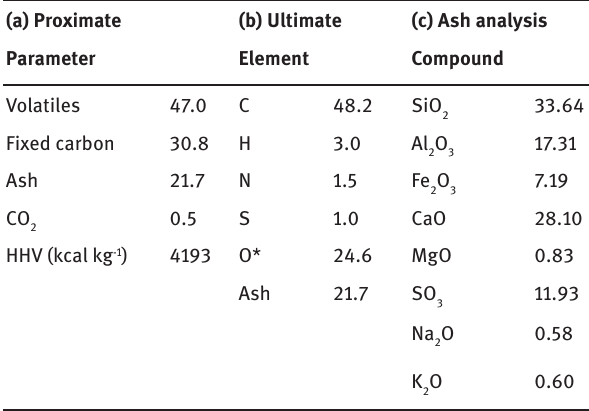
Table 1 : Proximate [ASTM D 7582-12], ultimate [ASTM D 5373-08]